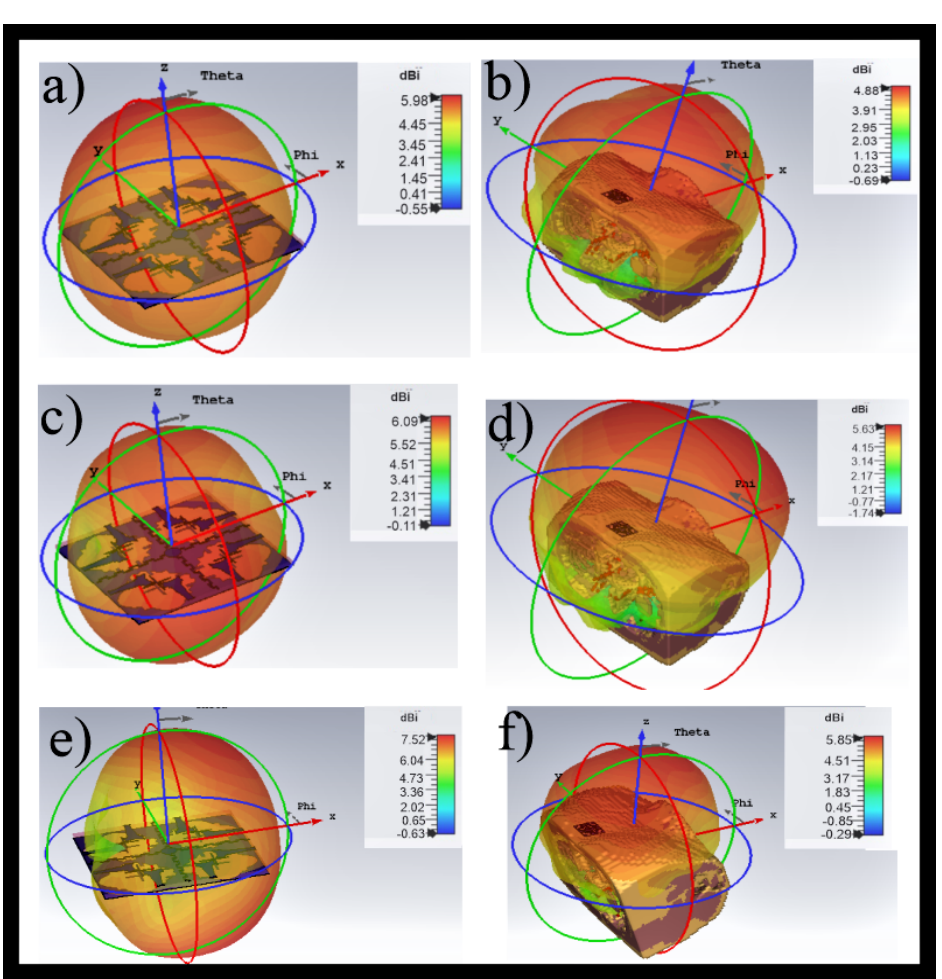
Figure 8. 3D Radiation patterns: ( a ) 3.5 GHz; ( c ) 5 GHz; ( e ) 7.5 GHz; ( b ) 3.5 GHz OB; ( d ) 5 GHz OB; ( f ) 7.5 GHz OB.